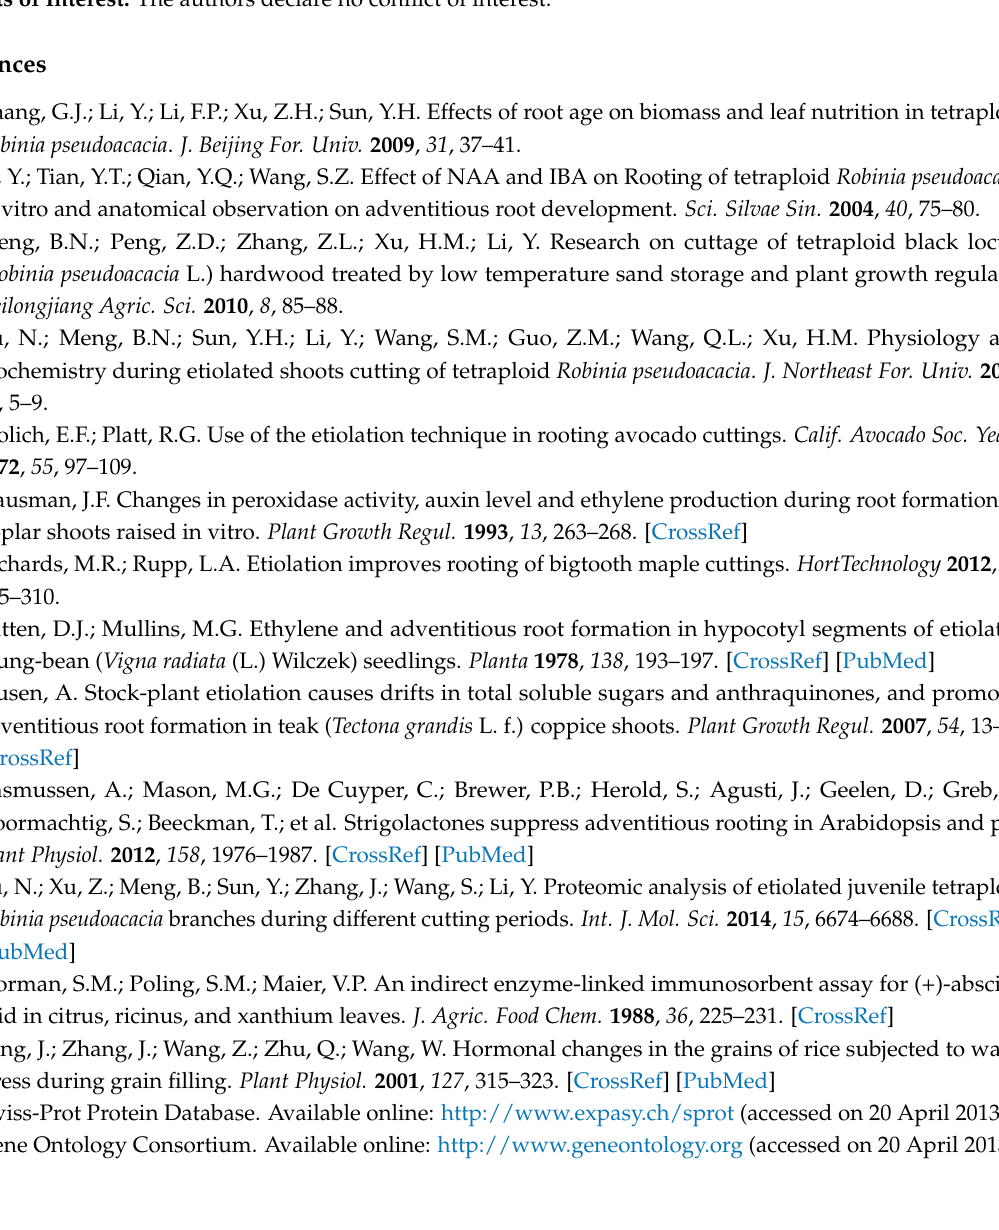
Table S1: List of the experimental individuals of R. pseudoacacia L., Table S2: Summary of the tetraploid R. pseudoacacia transcriptome, Table S3: Categorization of tetraploid R. pseudoacacia with KEGG biochemical pathways, Table S4: The GO analysis of the DETs, Table S5: The KEGG analysis of the DETs, Table S6: Top 20 up- and downregulated genes in response to etiolation, Table S7: Transcript expression level of part differentially expressed